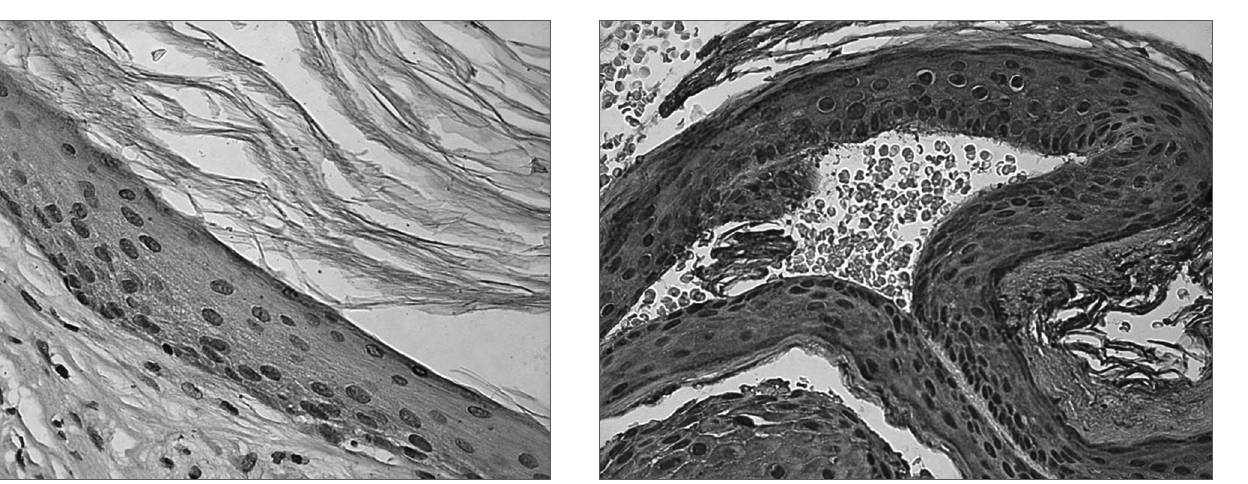
Figure 1. Microphotography from a cholesteatoma fragment, in which we see a weak reaction against the TNF-R2 receptor in the cytoplasm of the matrix keratinocytes (IHQ X400).